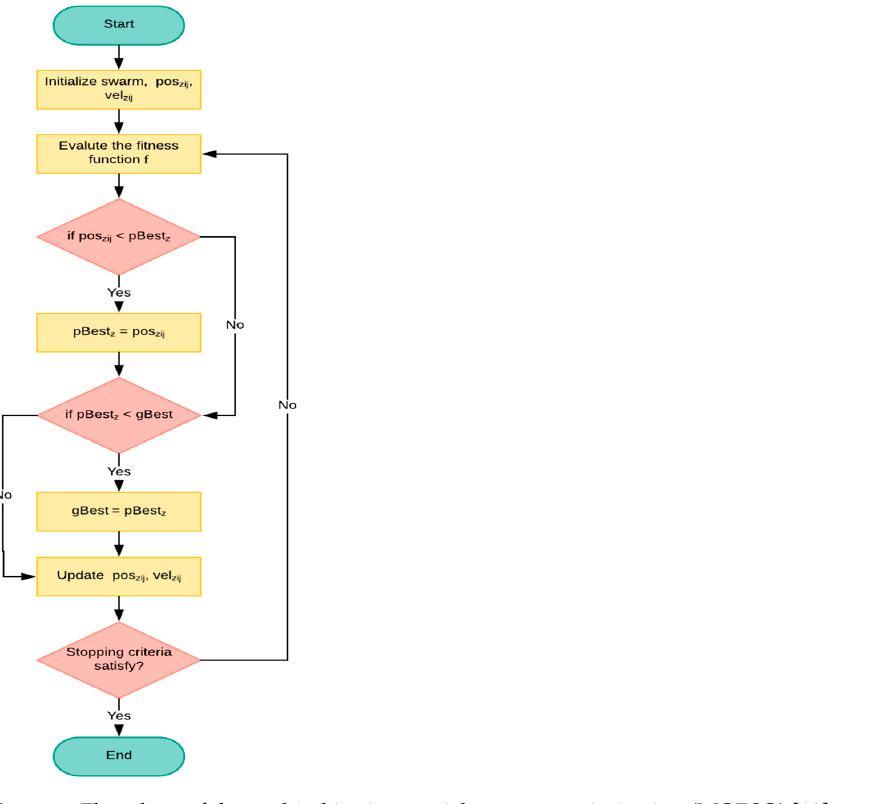
Figure 4. Flowchart of the multi-objective particle swarm optimization (MOPSO) [19].